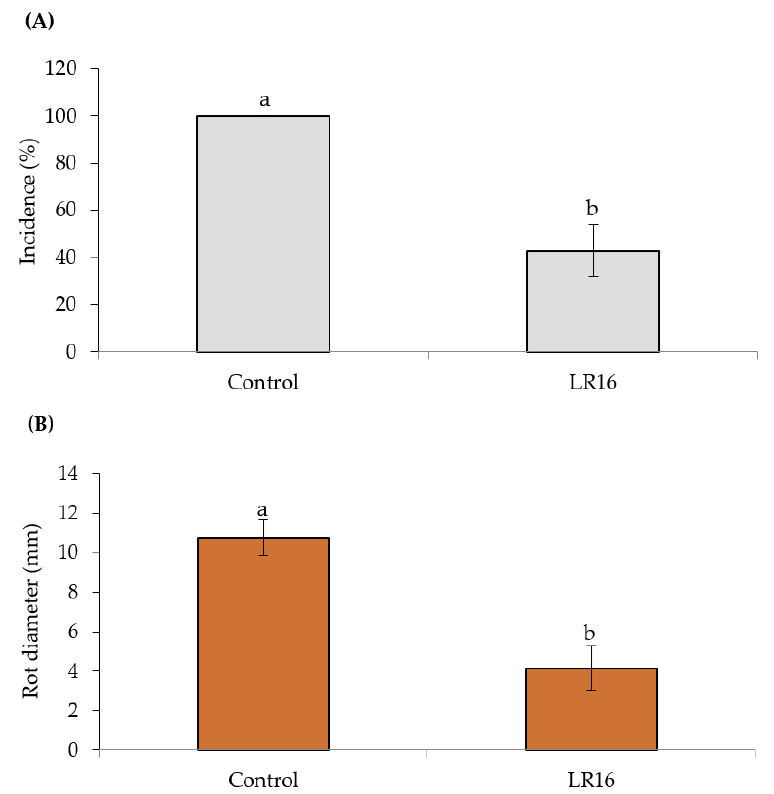
Figure 8. Incidence ( A ) and severity ( B ) of Phlyctema vagabunda (CP13 isolate) in apples treated with 0.5% propolis LR16. Letters indicate statistical differences ( t -test, p < 0.05) between treatments after 20 days of incubation at 20 °C.